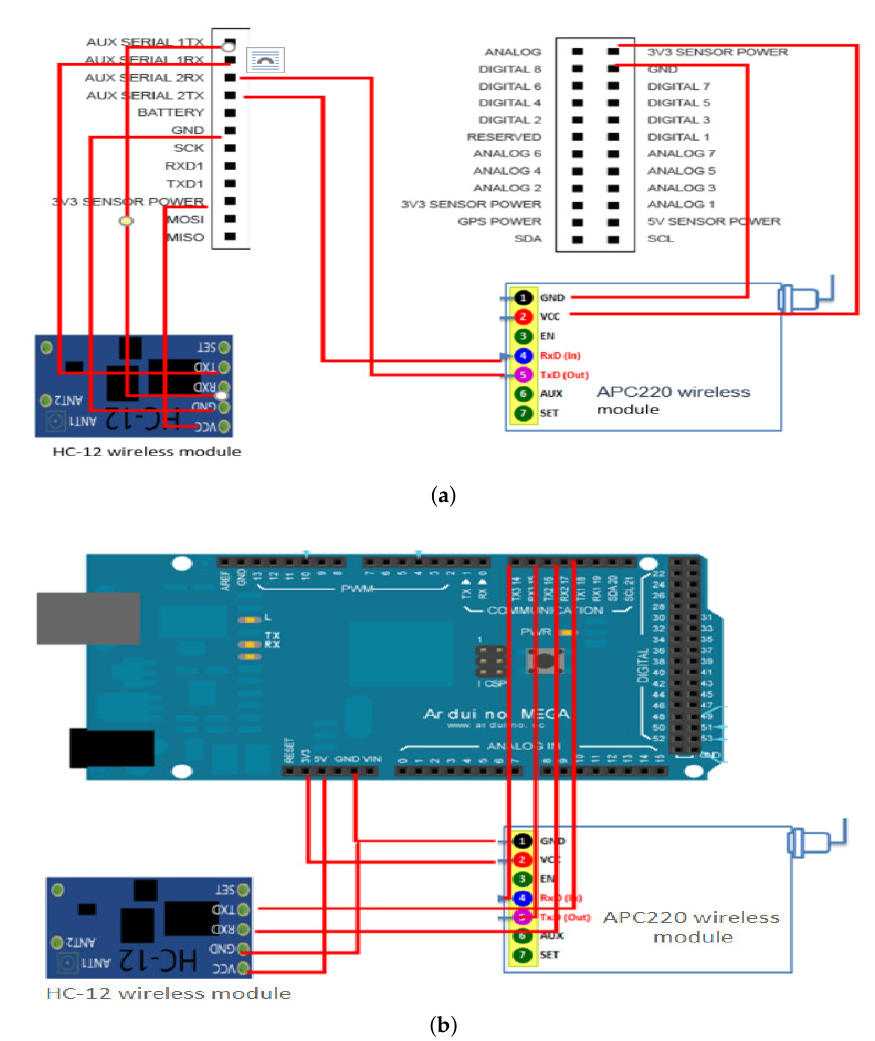
Figure 9. The wiring diagrams for the HC-12 and APC220 wireless modules with the ( a ) Waspmot ( b ) Arduino UART interfacing